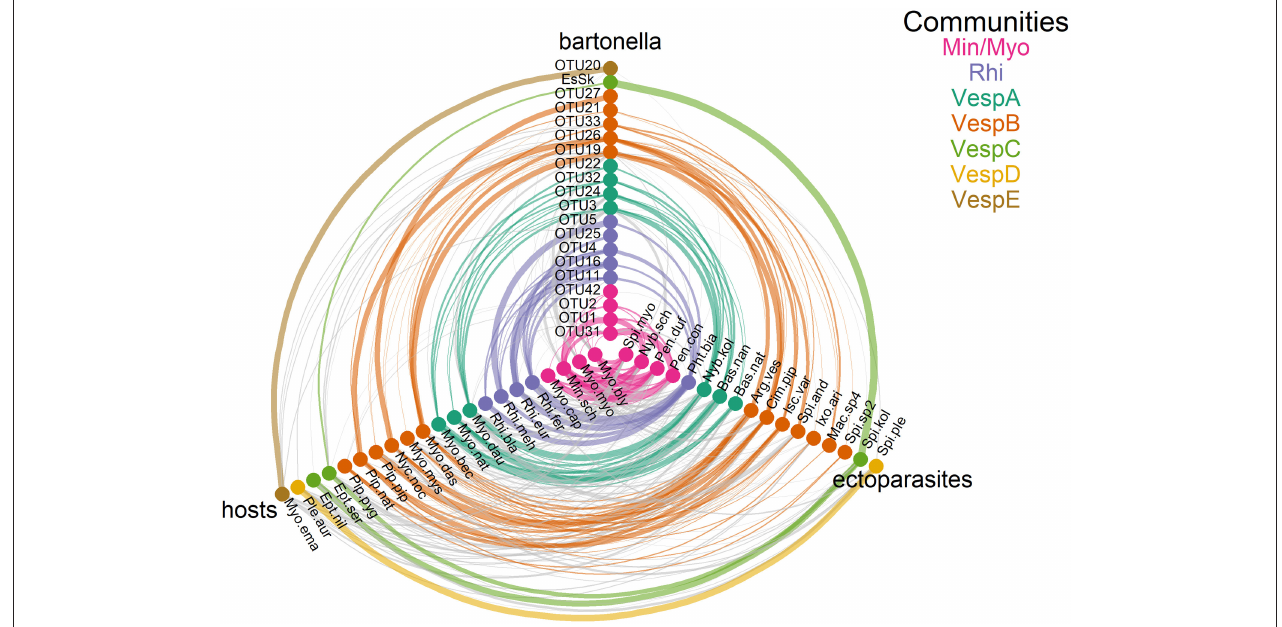
FIGURE 4 | Communities of Bartonella operational taxonomic units (OTUs), ectoparasite species, and bat species. Tripartite networks were drawn using separate axes for Bartonella , bats, and ectoparasite nodes. Edges connecting nodes were drawn based on Tables S3 and S10 , with edge weights adjusted for sampling intensity. Communities were identified by three detection algorithms (information map, Louvain, and spin glass). Species membership in each community is recorded in Table S14